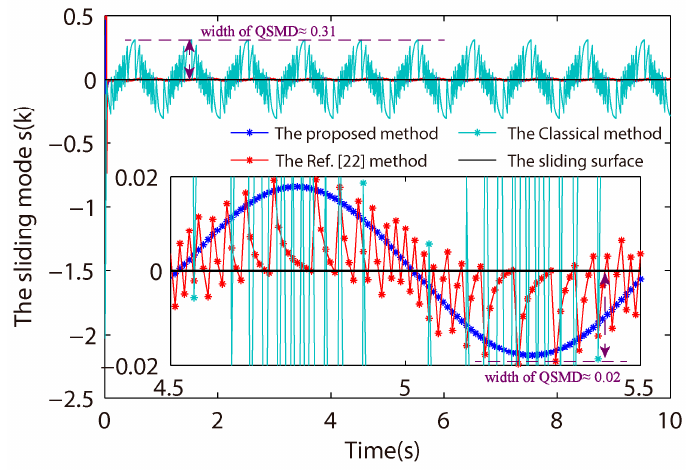
Figure 7. Sliding mode trajectory contrast curves.